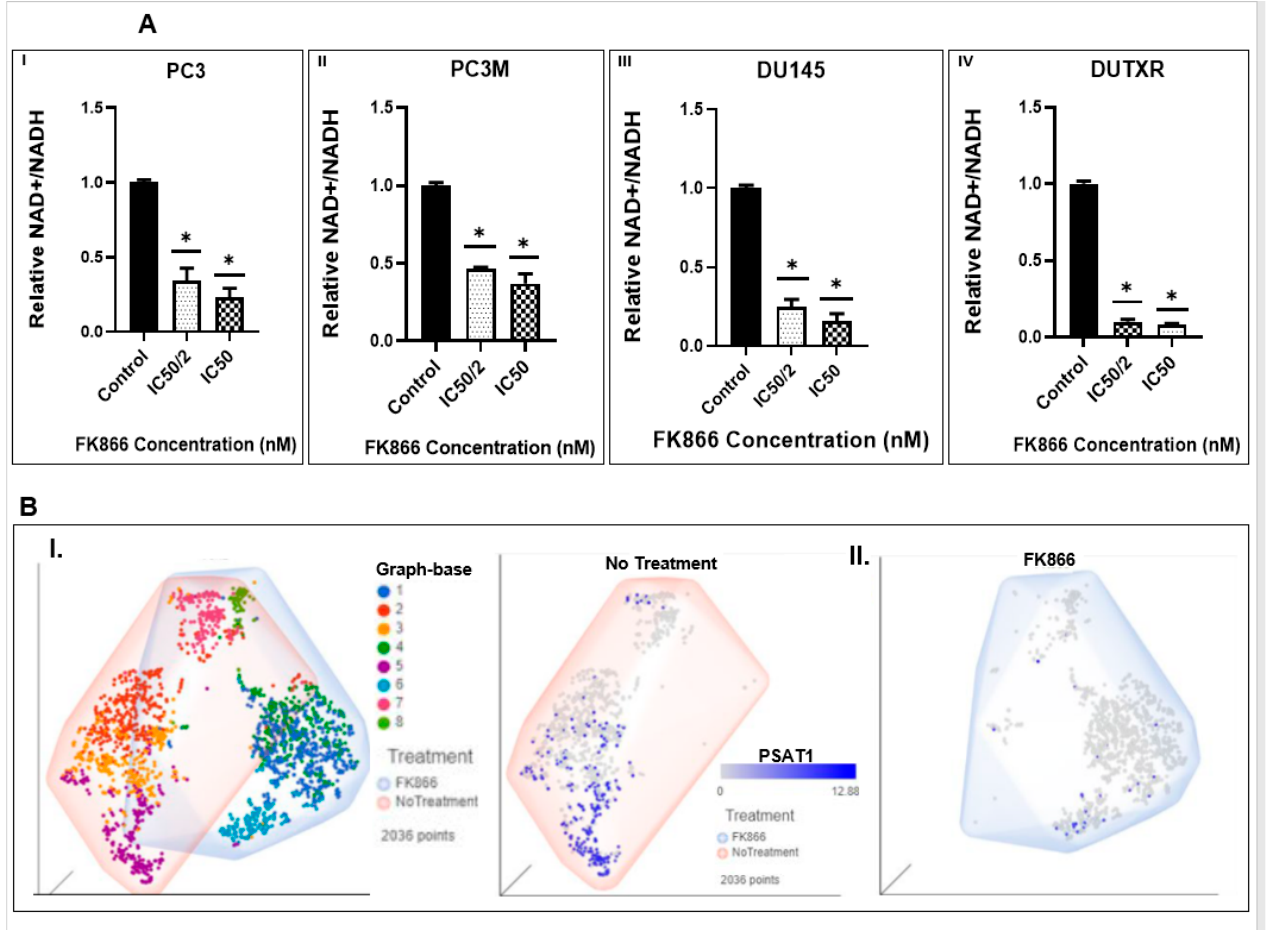
Figure 7. FK866 showed selective on-target inhibition of NAMPT activity. ( A ) FK866 post-treatment NADH activity: Effect of FK866 on total cellular NAD+/NADH ratio in PCa cell lines was detected by NADH activity assay in AR lo mCRPC (I. PC3, II. PC3M, III. DU145) and in Acquired taxane resistant mCRPC (IV. DUTXR) cell lines treated with FK866 doses equivalent to IC50 and IC50/2 of each cell lines. A significant decrease in the NAD+/NADH ratio was observed compared to control cells after 24 h of treatment. Results are presented as mean ± SD; n = 3 for each experiment (* p < 0.05, compared to untreated controls). ( B ) Pre- vs. Post-treatment scRNAseq data analysis: Effect of NAMPT inhibitor (FK866) on the sub-clonal population of human prostate cells in vitro following single-cell transcriptomics analysis. I. Pre- vs. post-treatment t-SNE clusters, showing II. Erosion of the PSAT1 high cluster (Cluster 5) in the FK866-treated scRNAseq data.